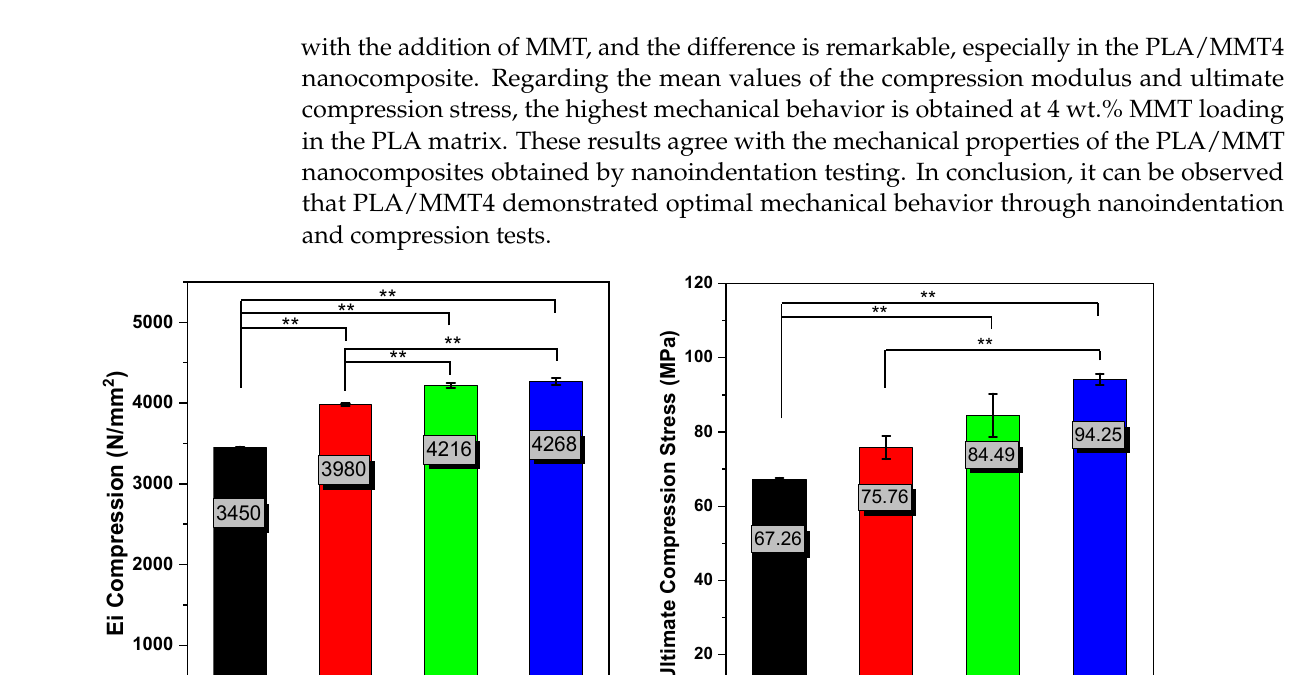
( b ) Figure 9. Effect of MMT content on the ( a ) hardness and ( b ) elastic modulus of PLA/MMT filaments. * p ≤ 0.05, ** p ≤ 0.01. Compression tests were conducted to investigate the mechanical response of the PLA/MMT nanocomposites with three different MMT loadings. Figure 10a,b shows the compression results of the PLA/MMT 3D-printed solid specimens compared to the PLA values. The average and standard deviation of compressive modulus were equal to 3450